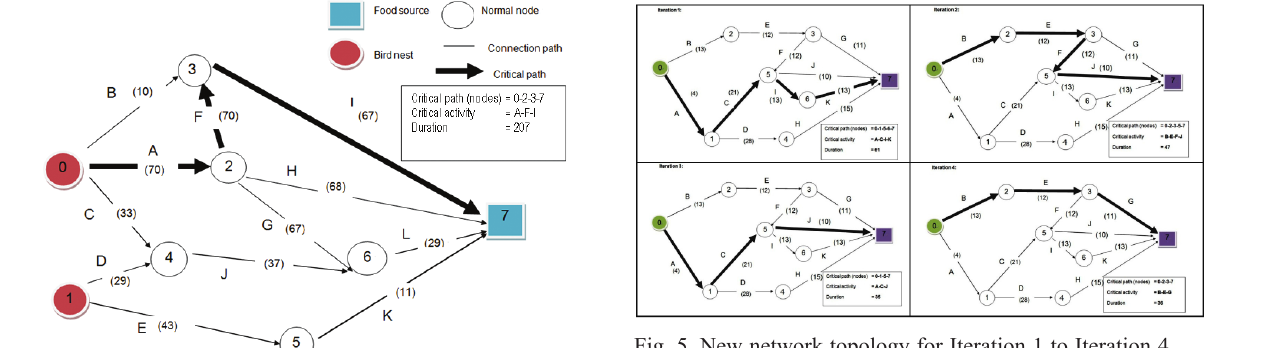
Fig. 5. New network topology for Iteration 1 to Iteration